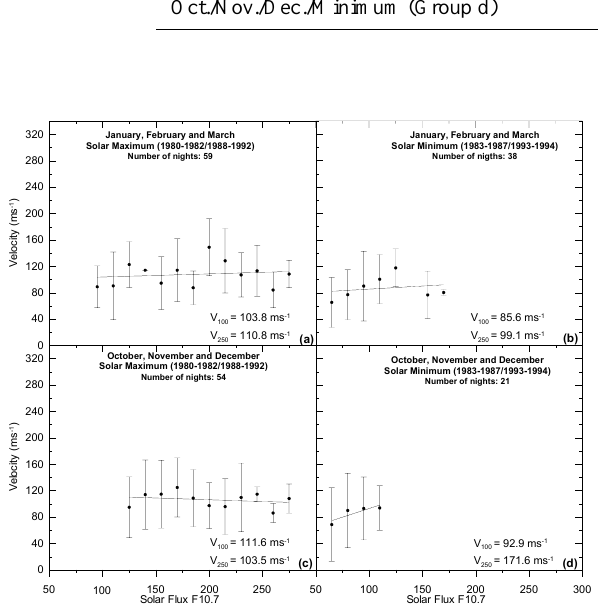
Figure 2. Same as Figure 1 except for the Solar Flux F10.7 cm parameter horizontal Fig. 2. Same as Fig. 1 except for the Solar Flux F10.7cm parameter axis. The plasma bubbles zonal drift velocities were obtained in the interval between 18LT and 22:45LT . horizontal axis. The plasma bubbles’ zonal drift velocities were obtained in the interval between 18:00 LT and 22:45 LT.